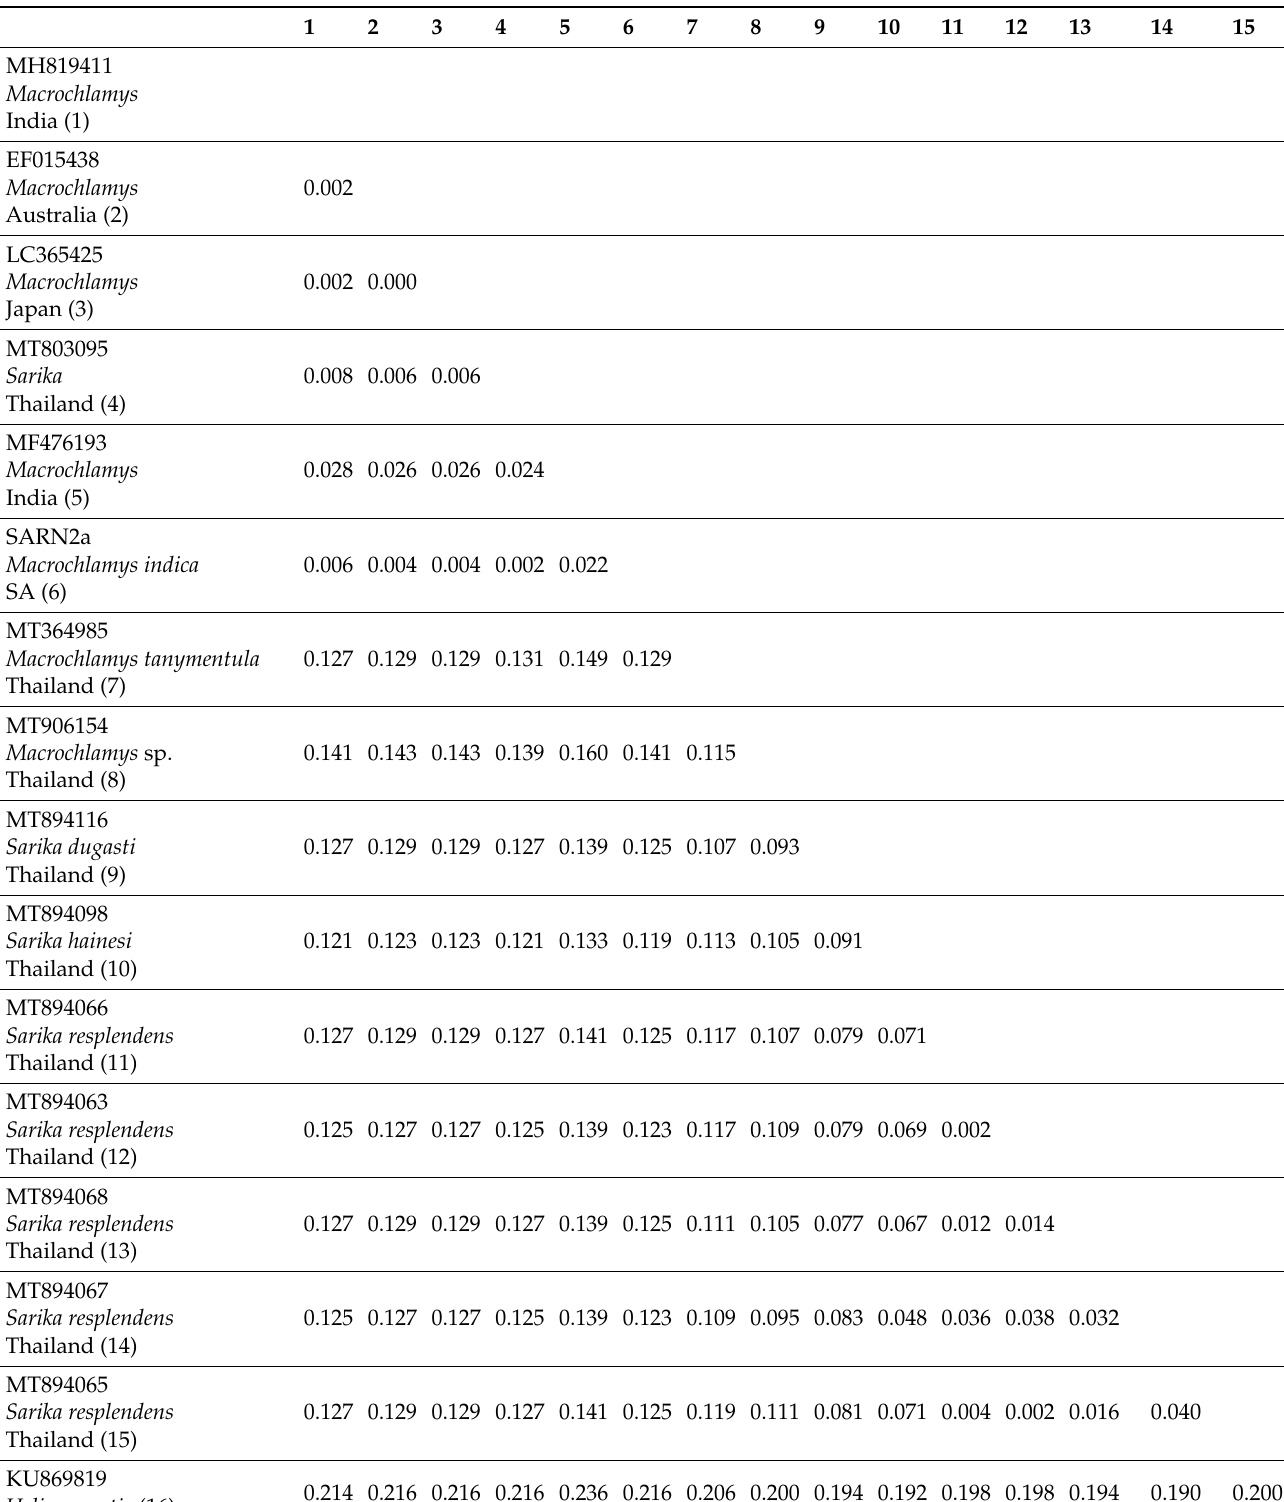
Table 4. Pairwise p-distances calculated from COI sequences from Macrochlamys and their closely relative